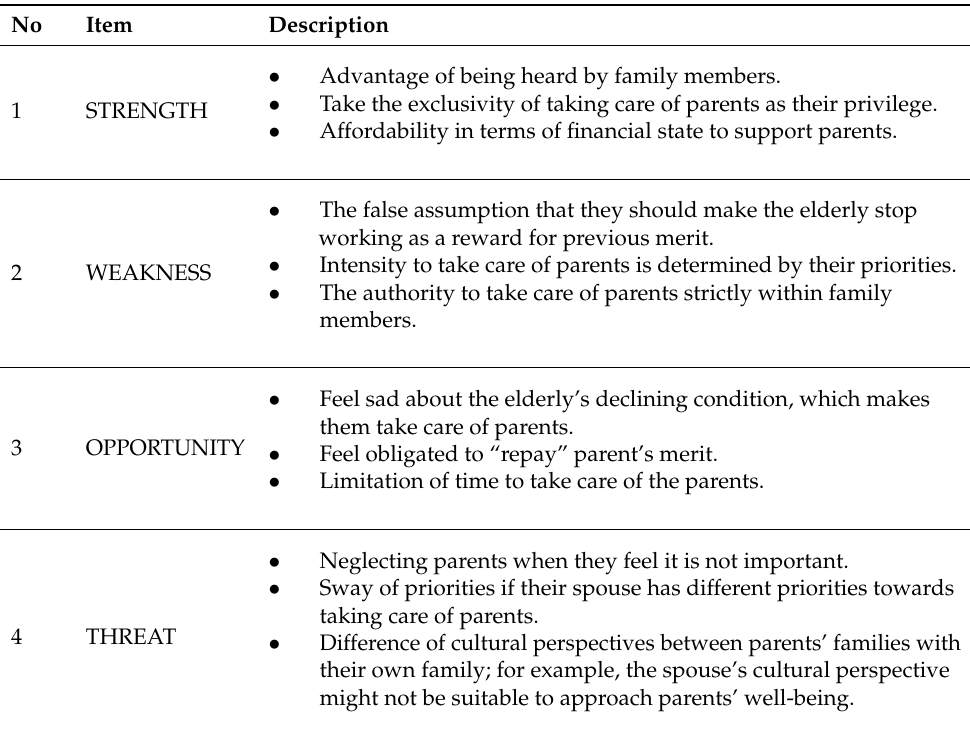
Table 4. Dominant children